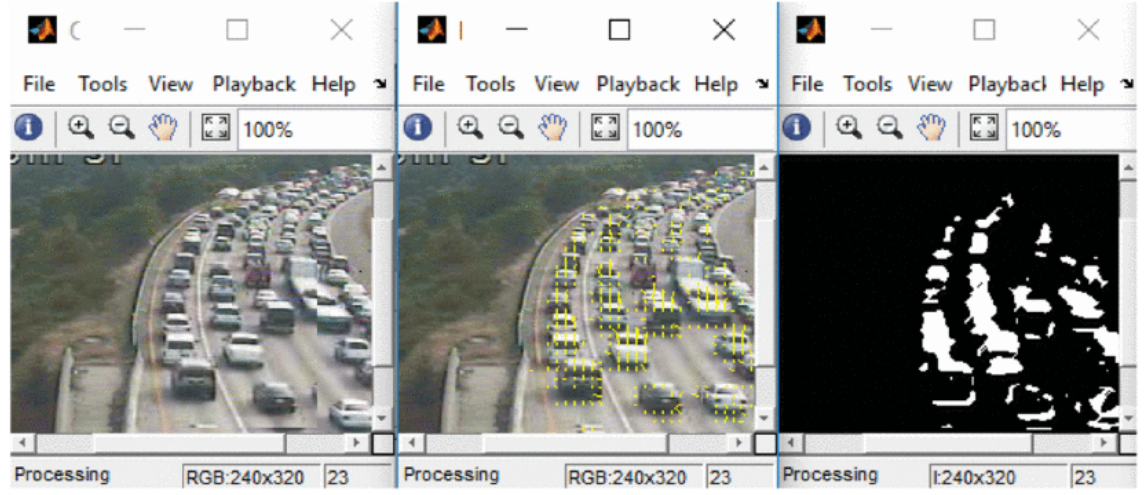
Fig. 4. Estimating total vehicles count (east bound and west bound traffic)